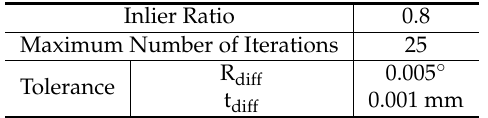
Table 1. Based on the given inlier ratio, specifying the percentage of matched points considered as inliers, the algorithm is estimating the optimal rigid body transformation between both sets of points. Table 1. Parameterisation of the iterative closest points (ICP) registration algorithm.